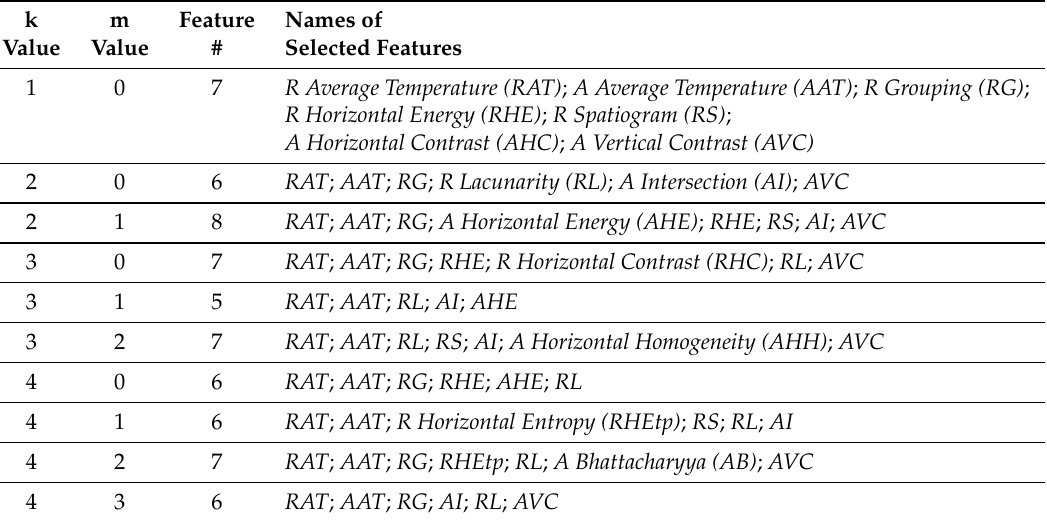
Table 3. Selected features for each series